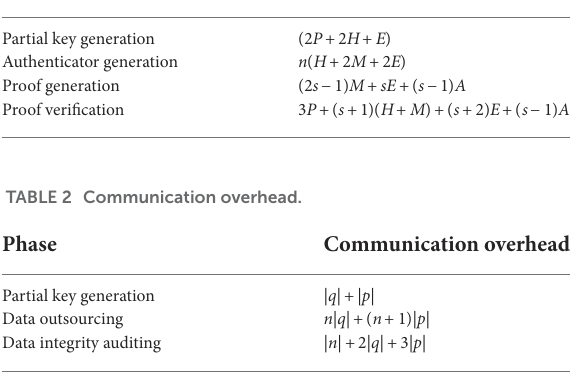
TABLE 1 Computation overhead in different phases. Phase Computation overhead Partial key generation